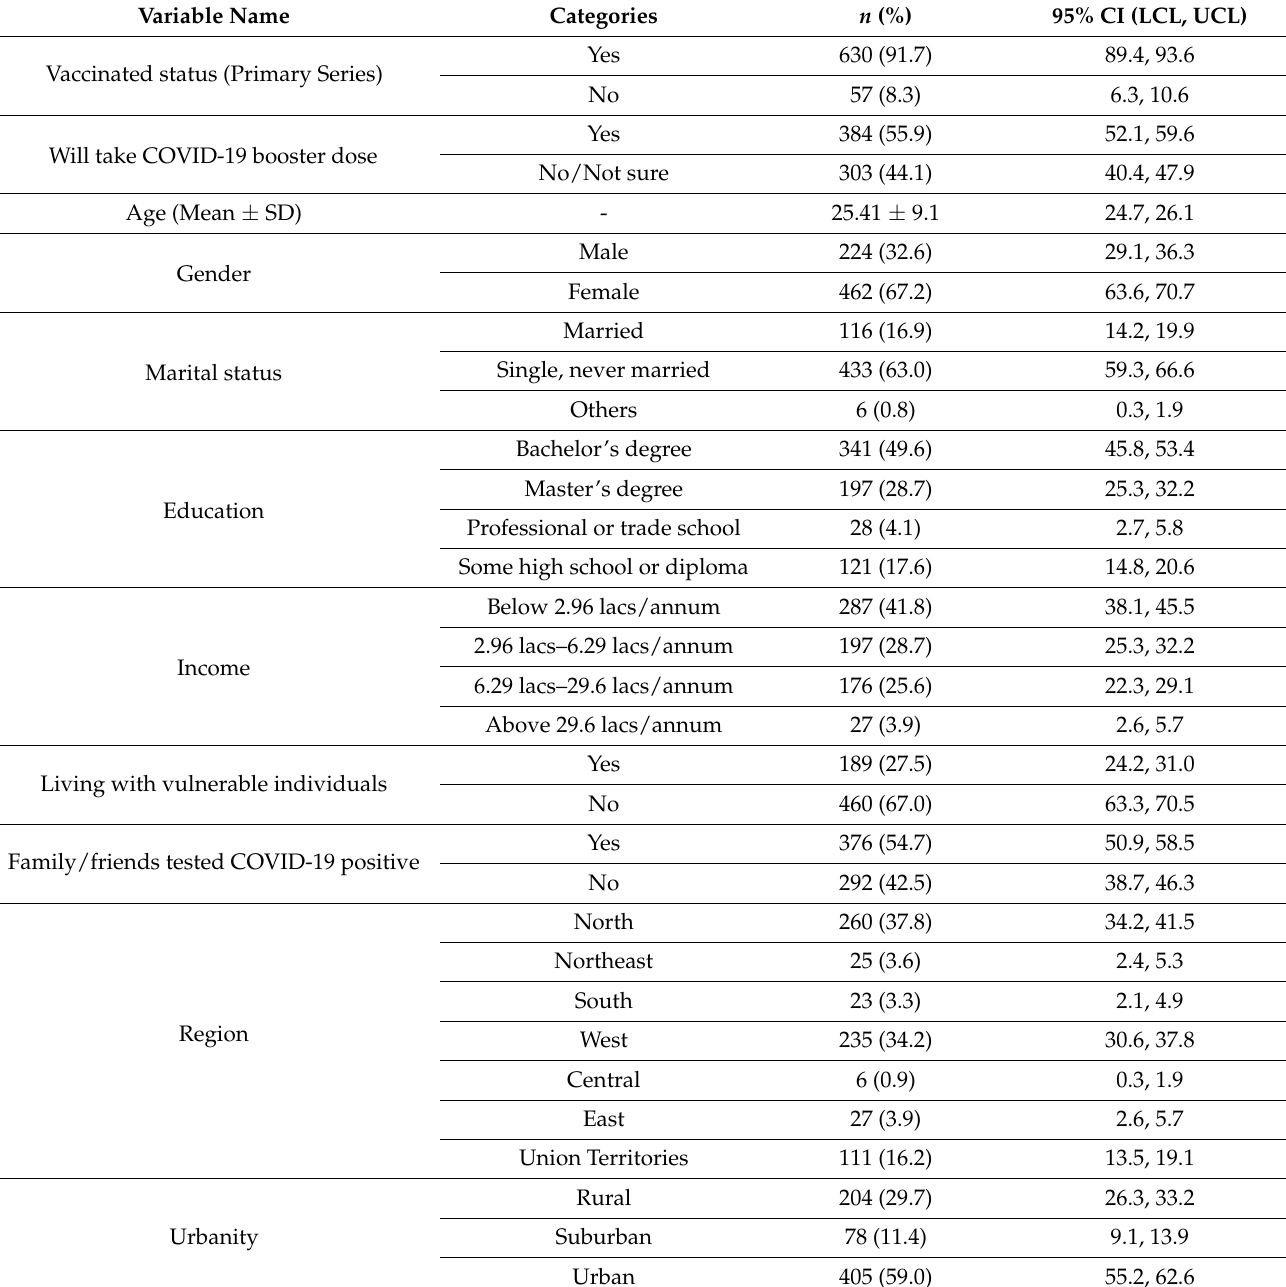
Table 1. Demographic characteristics of the respondents ( n =